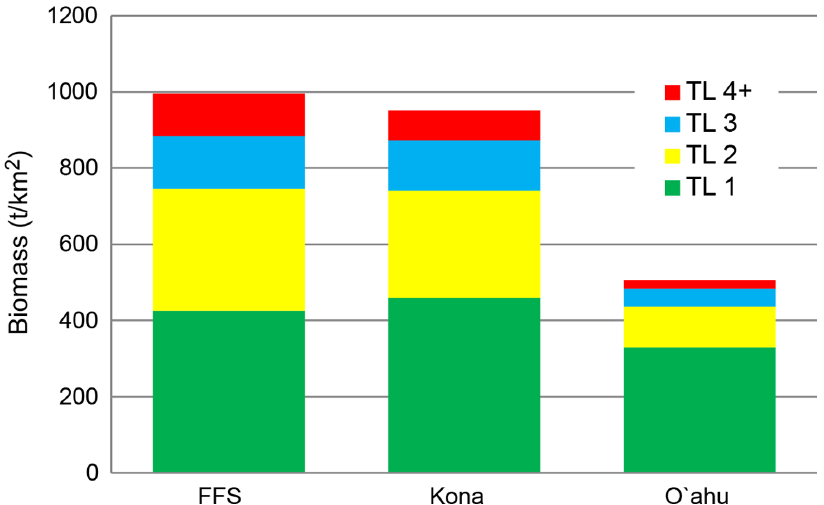
Figure 3. Composition of biomass (t/km 2 ) per trophic level (TL) for the three systems studied in Hawai’i. FFS is French Frigate Shoals; Kona represents the Kona Coast of Big Island.